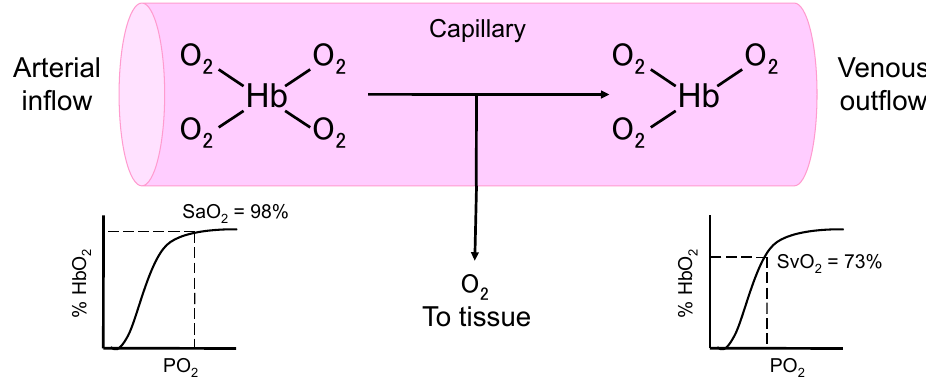
Figure 1. The delivery of oxygen molecules by the hemoglobin (Hb) to the peripheral tissue. Depending on the oxygen tension of the tissue, one or several oxygen molecules will be released from the oxyhemoglobin (HbO 2 ) and diffuse from the capillary (pink area) into the tissue. The fraction of oxyhemoglobin relative to total hemoglobin in arterial blood is the arterial oxygen saturation (SaO 2 , as percentage), which is normally >95%. Normal mixed venous oxygen saturation (SvO 2 ) is about 65–75%. A decrease in SvO 2 usually indicates low tissue oxygen tension, resulting in increased extraction of oxygen molecules from the hemoglobin. Figure adapted from [35].